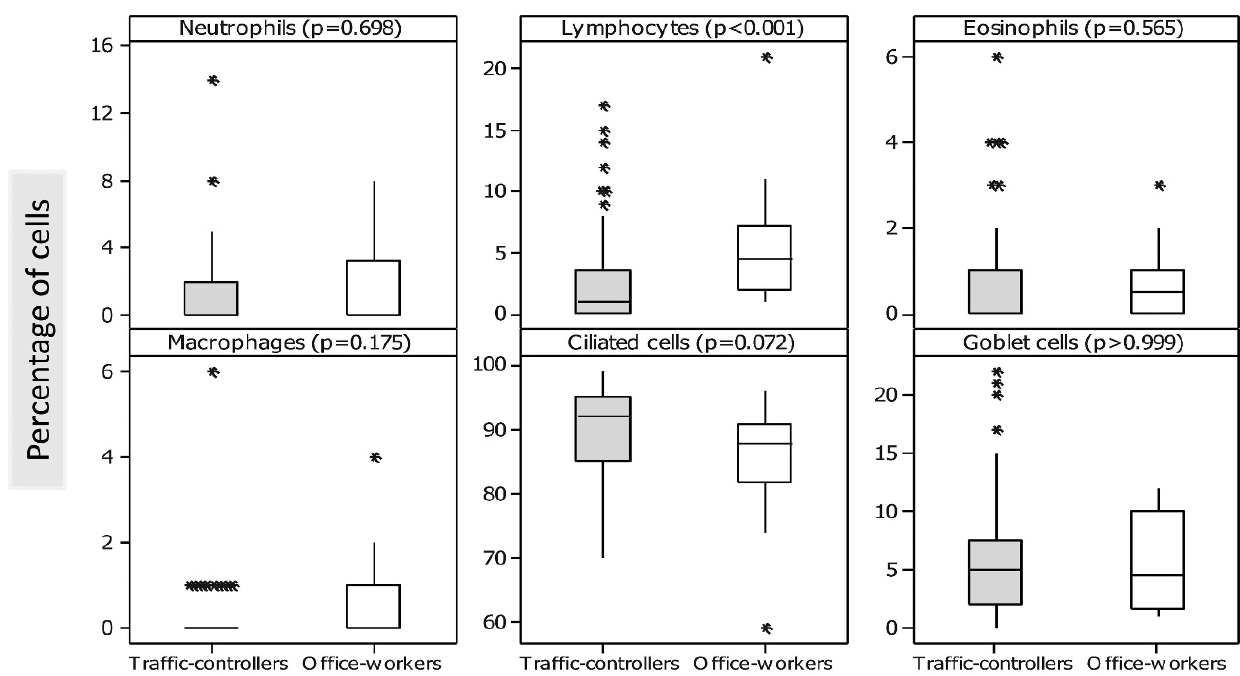
Figure 2 - The proportions of cells (%) in the nasal lavage fluid of the traffic-controllers and office-workers. The data were analyzed by the